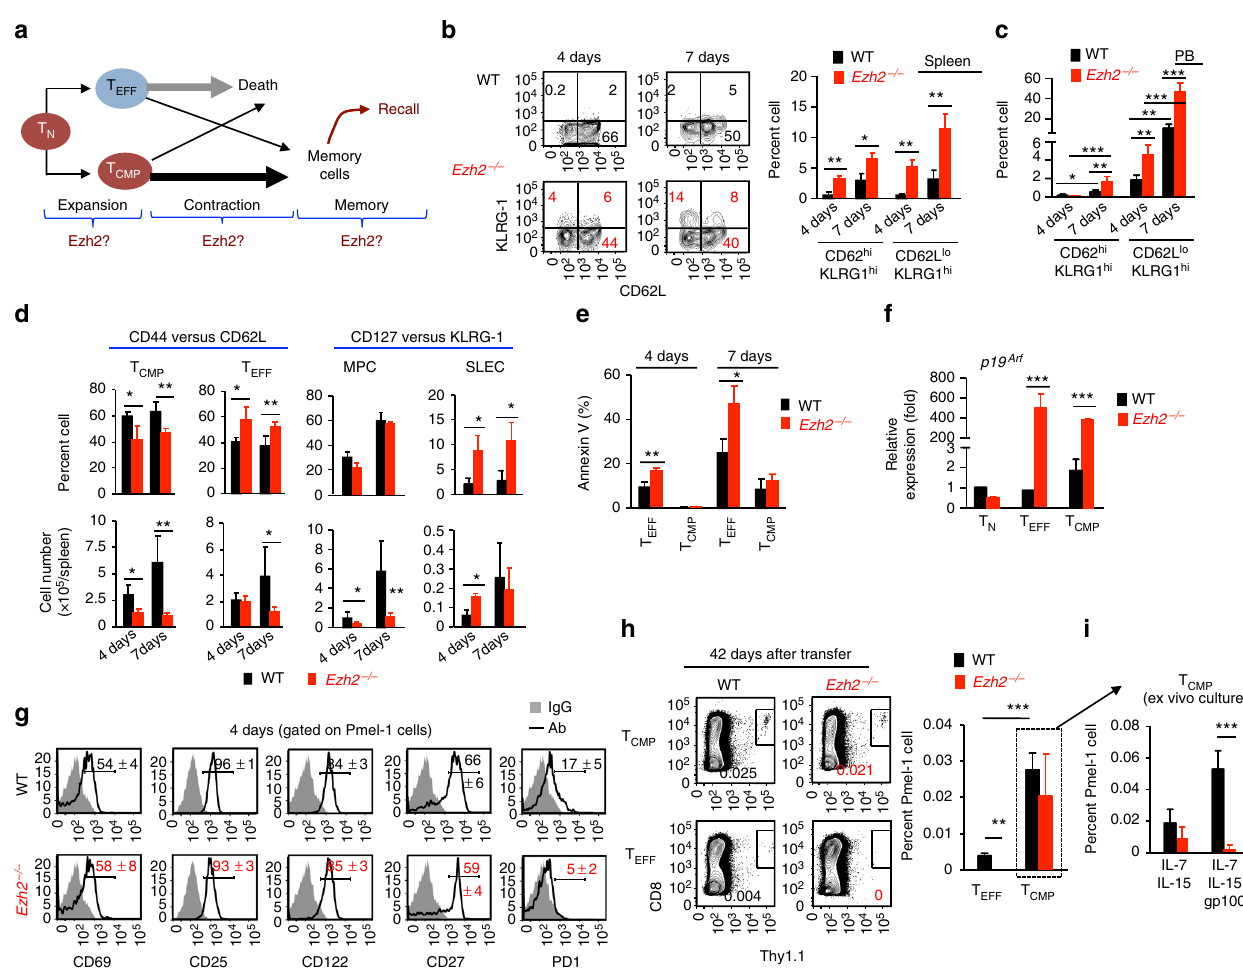
Fig. 2 Ezh2 helps establish memory properties in activated CD8 + T cells early during expansion. a Schematic diagram of three characteristic phases of the T-cell response and the possible role of Ezh2 in each phase. b – g WT and Ezh2 − / − naive Pmel-1 cells (Thy1.1 + ) were transferred into sublethally irradiated non-tumor-bearing B6 mice (Thy1.2 + ), followed by immediate treatment with IL-2 and gp100-DCs for 3 days. Donor T cells were recovered at 4 days and 7 days after transfer. Plots and graphs show the percentage of KLRG-1-expressing (KLRG1 hi ) T CMP and T EFF in the spleen ( b ) and PB ( c ). d Graphs show the percentage and numbers of T CMP and T EFF (left panel) in the spleen at 4 days and 7 days after transfer. The right panel shows the percentage and numbers of MPCs and SLECs measured with KLRG-1 and CD127 at 4 days and 7 days after transfer. e The percentage of Annexin V-positive cells in the subpopulation of T CMP and T EFF at 4 days and 7 days after transfer. f Real-time RT-PCR measurement of p19 Arf in the subset of T CMP and T EFF of 4 days and 7 days. g Histograms show the expression of indicated surface markers on WT and Ezh2 − / − T cells derived from the spleen at 4d after transfer. h , i WT and Ezh2 − / − naive Pmel-1 cells (Thy1.1 + ) were transferred into sublethally irradiated non-tumor-bearing B6 mice (Thy1.2 + ), followed by immediate treatment with IL-2 and gp100-DCs for 3 days. By 7 days after transfer, donor T CMP and T EFF were highly puri fi ed using FACS sorter, and transferred into sublethally irradiated secondary recipients that had been immunized with gp100-DCs 7 days earlier (described in Supplementary Fig.4). Forty-two days later, donor T cells were collected from the spleen of these secondary recipients ( h ), and further cultured ex vivo for additional 5 days ( i ). Plots and graphs show the frequency of donor T cells derived from the secondary recipients of WT and Ezh2 − / − T CMP and T EFF . * p < 0.05, ** p < 0.01, and *** p < 0.01 (two-tailed unpaired t test). The data are representative of four independent experiments with n = 3 mice per group in each ( b – g ; mean ± SD) or two experiments with n = 4 mice per group in each ( h , i , mean ±